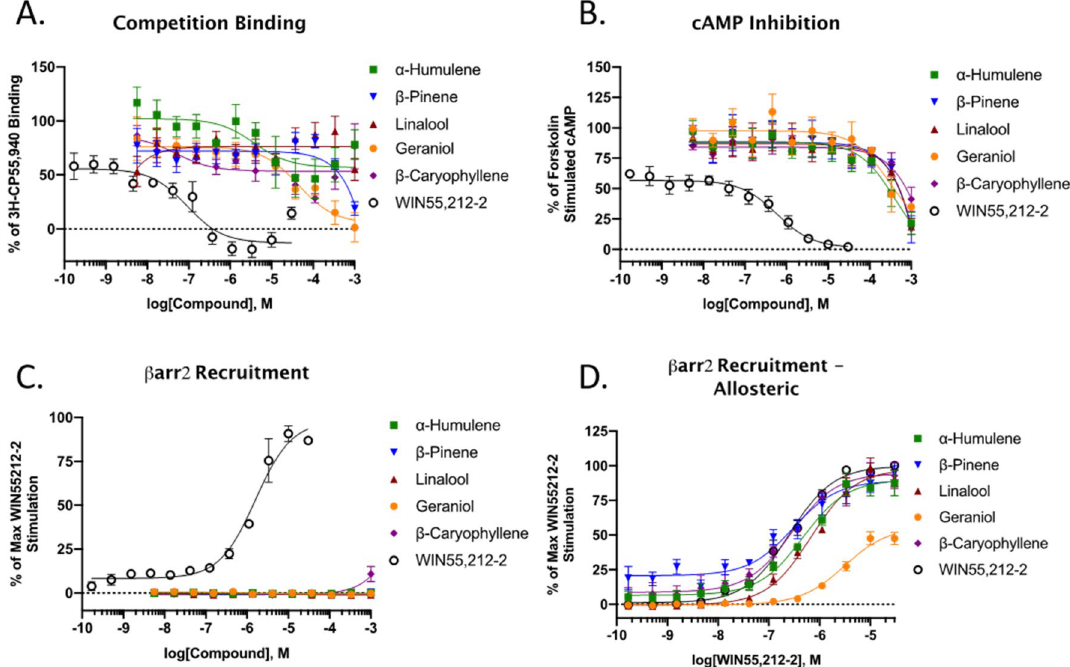
Figure 8. Binding and Functional Analysis of Terpenes at the CB1. Fitted curve values reported as the mean with the 95% confidence interval. ( A ) CB1-CHO membranes were subjected to competition binding assay with terpenes and WIN55,212-2 against 3 H-CP55,940. Data represents the mean ± SEM of specific binding (n = 5 independent experiments). IC 50 values: WIN55,212-2 = 90.4 nM (36–206); Geraniol = 44.2 μM (11.1–193). Other terpenes did not provide competition curves that could be fit. ( B ) CB1-CHO cells were treated with varying concentrations of terpene or WIN55,212-2 for 30 min. The ability to inhibit forskolin- stimulated cAMP accumulation was measured accordingly (see Methods). Data represents the mean ± SEM of % of forskolin-stimulated cAMP (n = 4 independent experiments). IC 50 value: WIN55,212-2 = 591 nM (289–1,180). Terpenes did not provide full inhibition curves. ( C ) CB1-CHO-DX cells were treated with varying concentrations of compounds and βarrestin2 recruitment was assessed after 1.5 h of treatment (see Methods). Data represents the mean ± SEM of max WIN55,212-2 recruitment (n = 3 independent experiments). EC 50 value: WIN55,212-2 = 1,600 nM (1,110–2,310). ( D ) CB1-CHO-DX cells were pretreated with 500 μM terpene for 5 min, followed by varying concentrations of WIN55,212-2 for 1.5 h (see Methods). Data represents the mean ± SEM of max WIN55,212-2 recruitment (n = 3 independent experiments). EC 50 values: WIN55,212-2 alone = 254 nM (194–331); WIN + Geraniol = 3,080 nM (2180–4350); WIN + α-Humulene = 471 nM (295–743); WIN + Linalool = 679 nM (480–956); WIN + β-Pinene = 302 nM (147–621); WIN + β-Caryophyllene = 283 nM